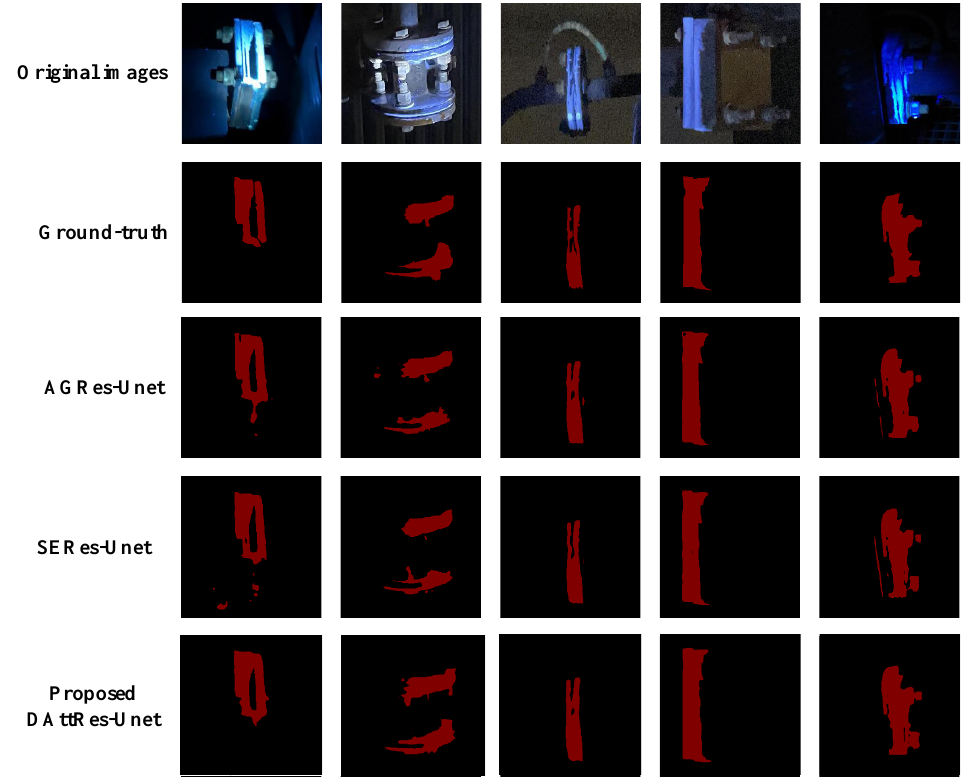
Figure 10. The segmented results of AGRes-Unet, SERes-Unet, and the proposed